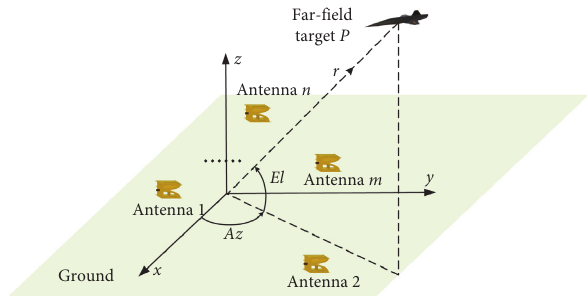
Figure 6: Multiple baseline